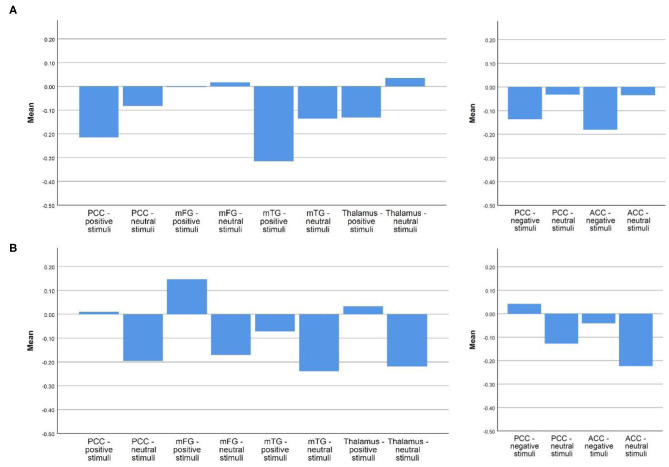
Mean betas in responders and non-responders in each region of interest during the perception of emotional vs. neutral stimuli. (A) Non-responder; (B) Responder. Depicted are the mean betas of responders and non-responders in our regions of interest in the respective emotional and neutral condition, the two graphs on the left site concern the regions more active in responders during the perception of positive stimuli, the two graphs on the right the ones more active in responders during the perception of negative stimuli.